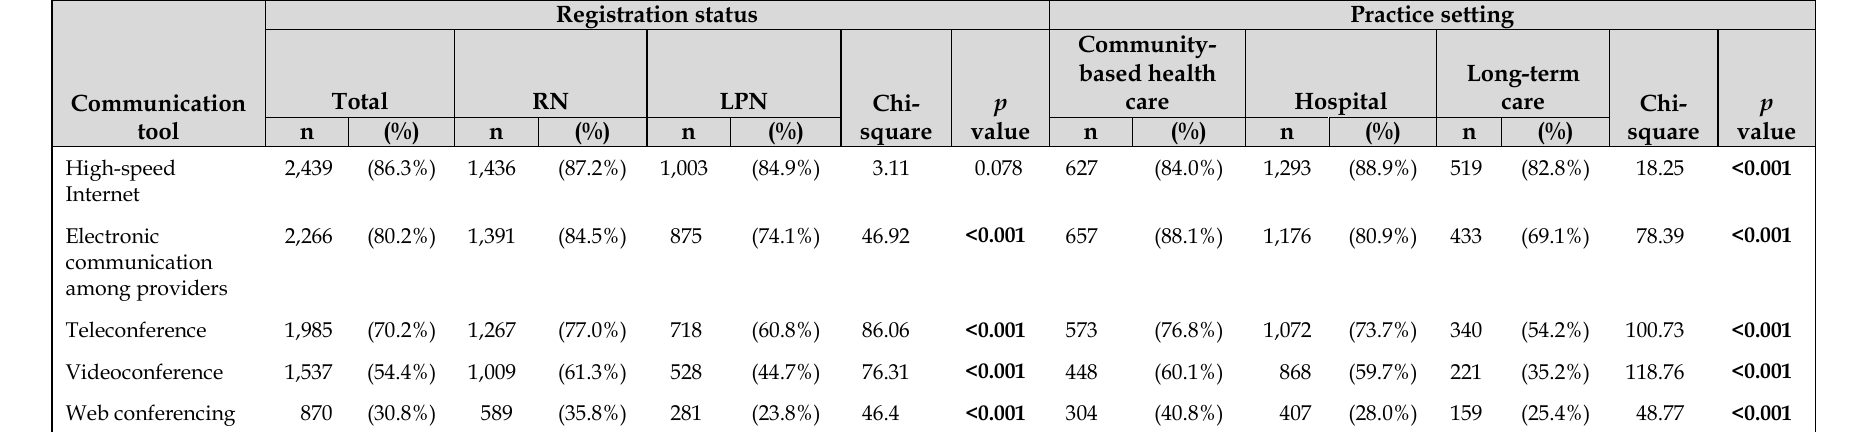
Table 2 Direct access to communication tools, by registration status and practice setting